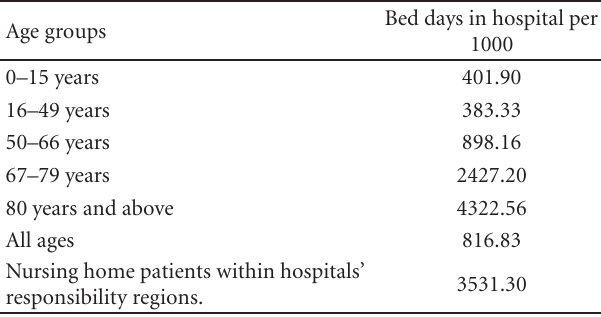
Table 1: Total number of age-specific hospital bed days (all departments and all diagnoses) in the Western Health Region of Norway as compared to hospital bed days among nursing home patients.